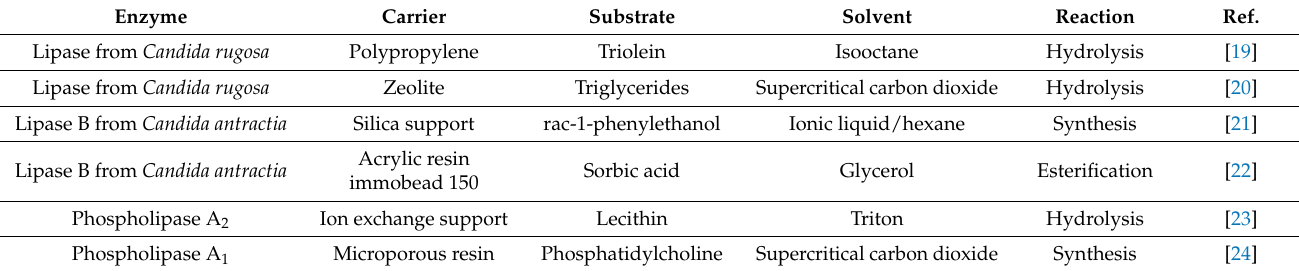
Table 1. Previous hydrophobic substrate reactions using immobilized lipases and phospholipases. Enzyme Carrier